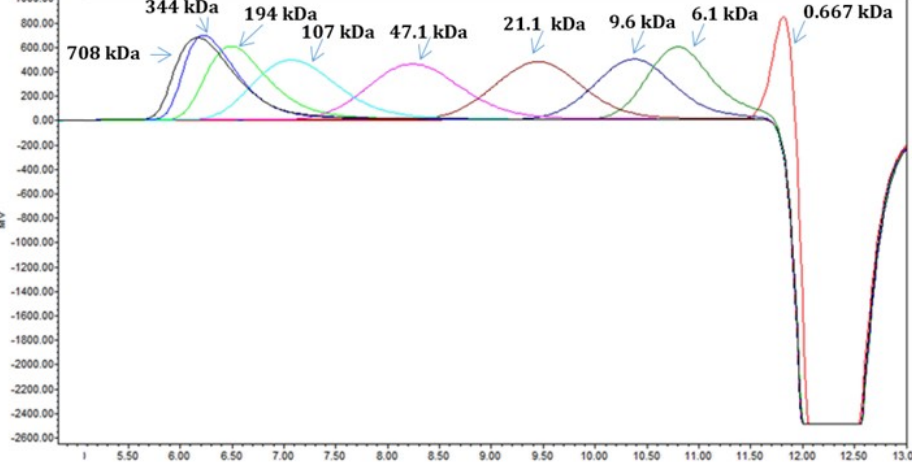
Figure 4. Identification of molecular mass and elution times of polysaccharide standards.